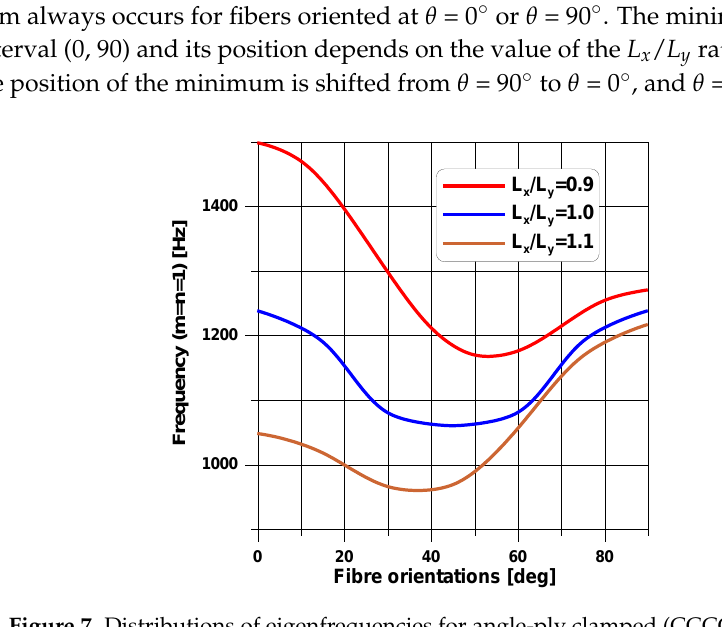
Figure 8. Contours of natural frequencies on the x , y plane for angle-ply and symmetric laminates— clamped (CCCC) plates. The next problem deals with the analysis of free-clamped (FFFC) rectangular plates (see Figures 9 and 10) that refer directly to the analysis of aeroelastic problems for composite wings applied to aircraft main structures. The numerical analysis demonstrates that the global minimum/maximum exists only independently of the plate aspect ratio. The maximal eigenfrequency occurs for plates having fibers oriented at θ = 90° and the minimal at θ = 0°. Figure 9. Distributions of eigenfrequencies for angle-ply free-clamped (FFFC) plates.